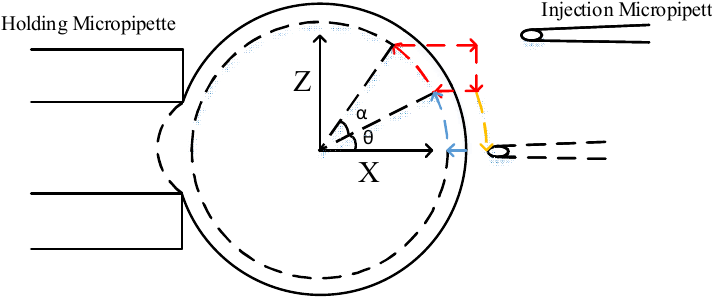
Figure 5. Rotation strategy of the first stage (front view).